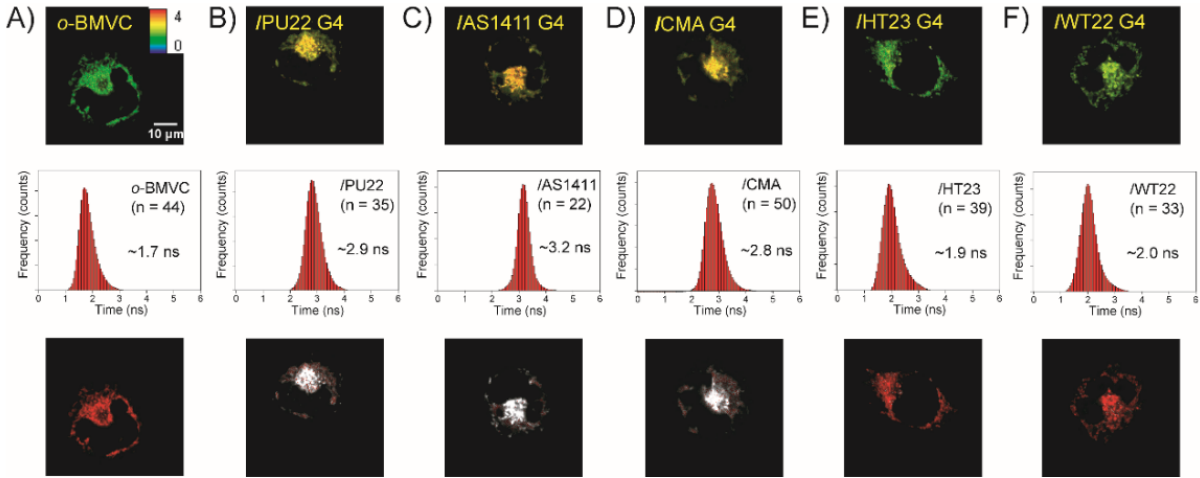
Figure 1. FLIM images of ( A ) 5 μ M o -BMVC and its complexes with the G4 structures of 15 μ M ( B ) PU22, ( C ) AS1411, ( D ) CMA, ( E ) HT23, and ( F ) WT22 when incubated with live CL1-0 cells for 2 h together with their histograms of the decay times of the o -BMVC fluorescence (n is the number of cells) and their time-gated FLIM images with the time threshold at 2.4 ns to separate the images into two colors: white (decay time ≥ 2.4 ns) and red (decay time < 2.4 ns), in live cell s.